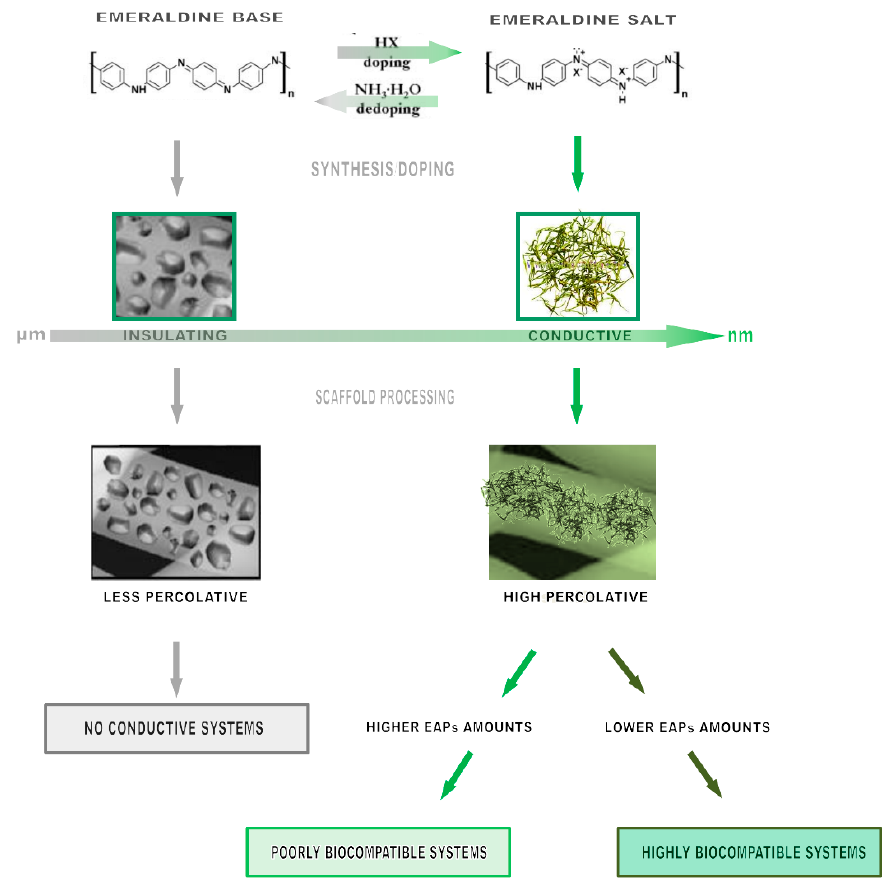
Figure 4. Schematic description of the biocompatibility of conductive platforms including EAPs: How conductive phase morphological features ( i.e. , shape, amount) can influence the transfer mechanisms of electrical signals.